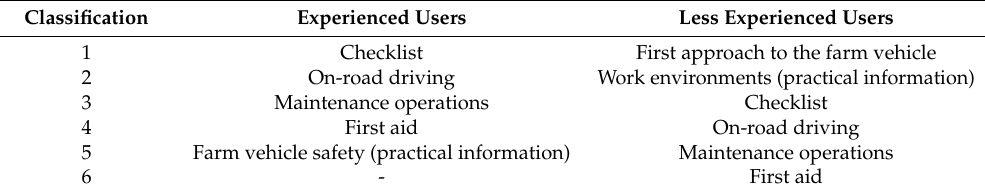
Table 3. Topics in order of usefulness for the interviewed users, separated according to experience.